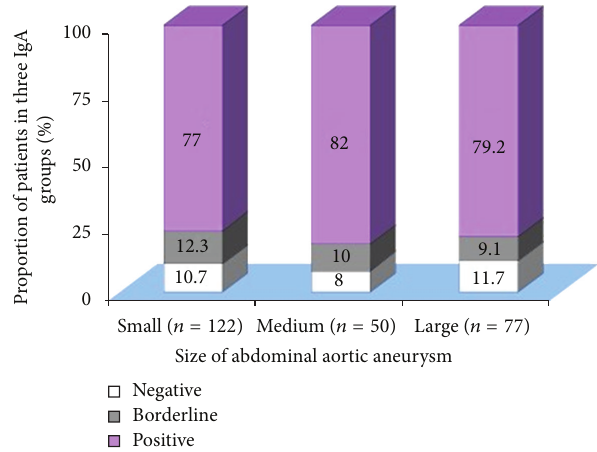
Figure 1: Comparison of the size of AAA based on IgA antichlamy- dial antibody titres. 𝜒 2 = 1.007 , df = 4 , and 𝑃 = 0.909 . 𝑛 : numbers in each